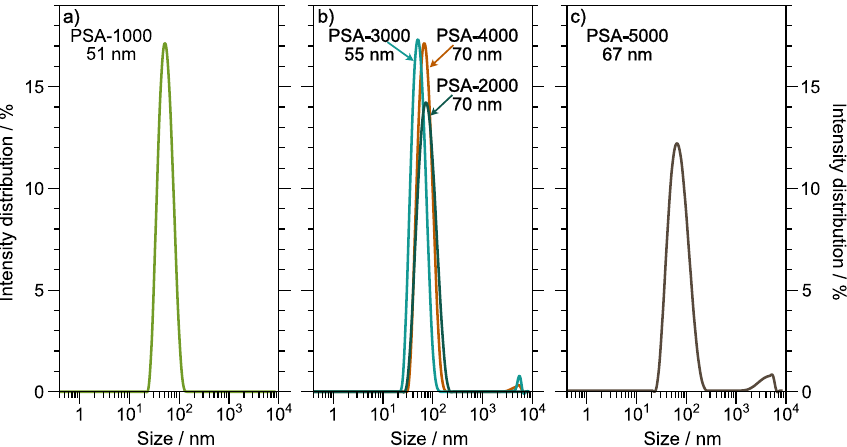
Figure 5. Particle size of copolymer latexes. ( a ) PSA-1000; ( b ) PSA-2000, PSA-3000, and PSA-4000; ( c ) PSA-5000.